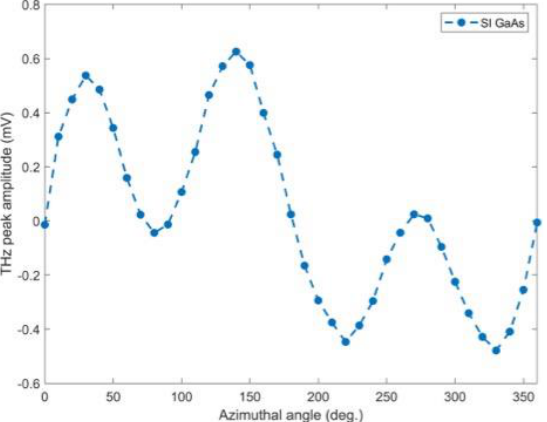
Figure 2. THz amplitude dependence of the azimuthal angle showing a trifold (120 ◦ ) symmetry indicate the optical rectification THz emission.